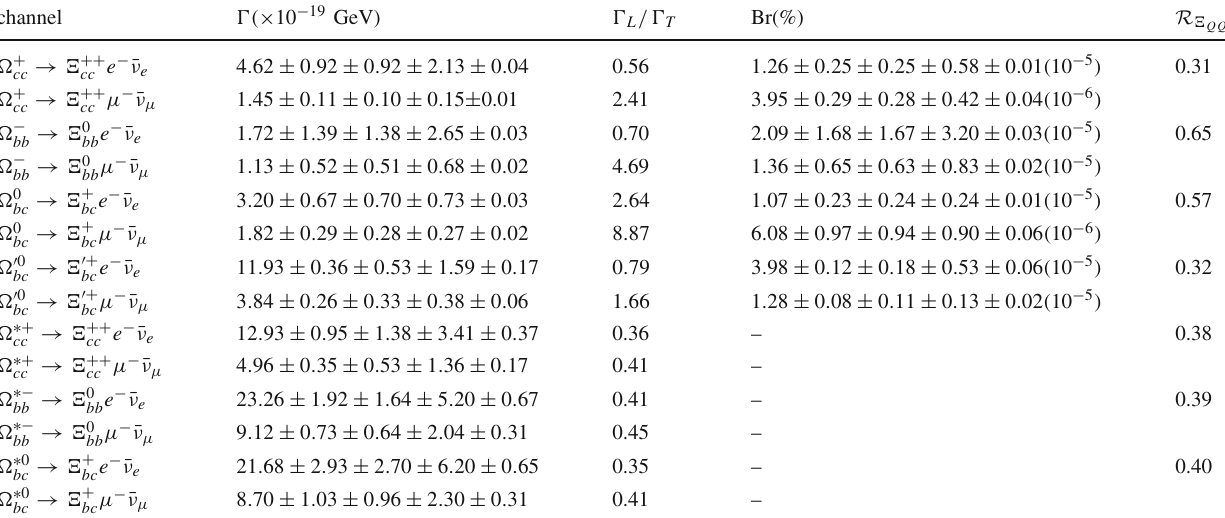
Table 5 Numerical results of decay widths and branching fractions in doubly heavy baryon semileptonic decays using the form factor F( q 2 ) in Eq. (31)